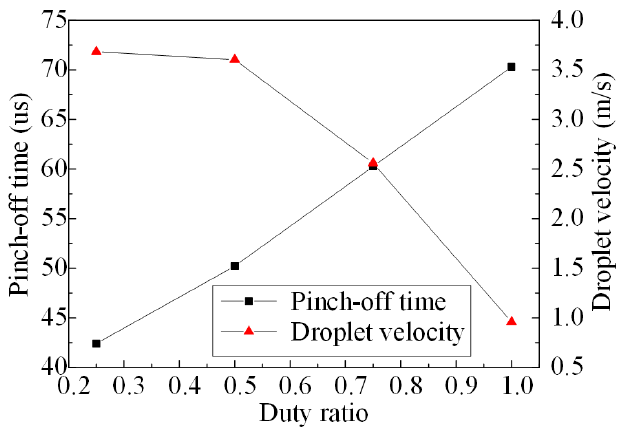
Figure 9. The pinch-off time and droplet velocity vary with different duty ratios.